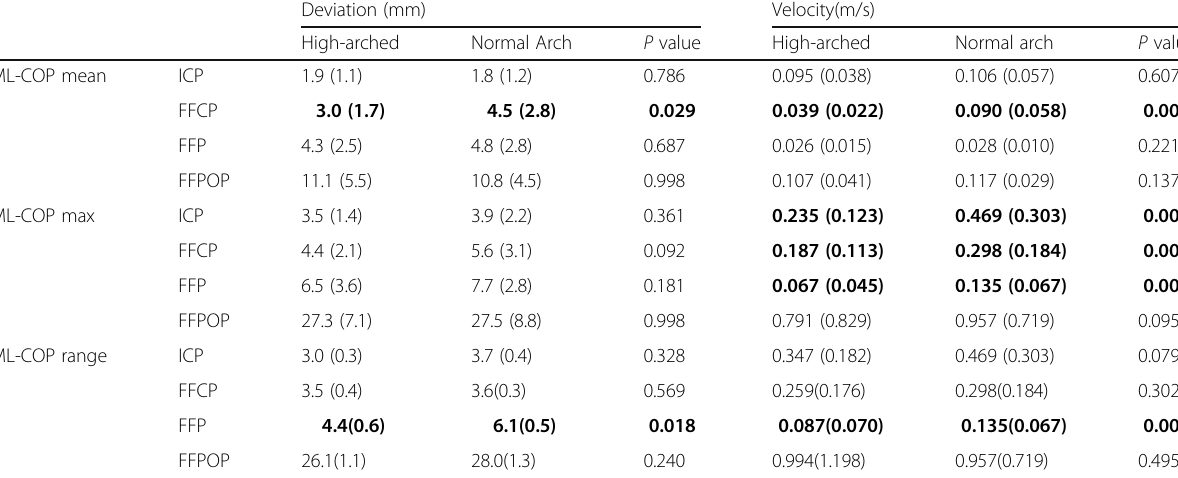
Table 2 Comparison of ML-COP deviation and velocity between high-arched and normal feet Deviation (mm) Velocity(m/s) High-arched Normal